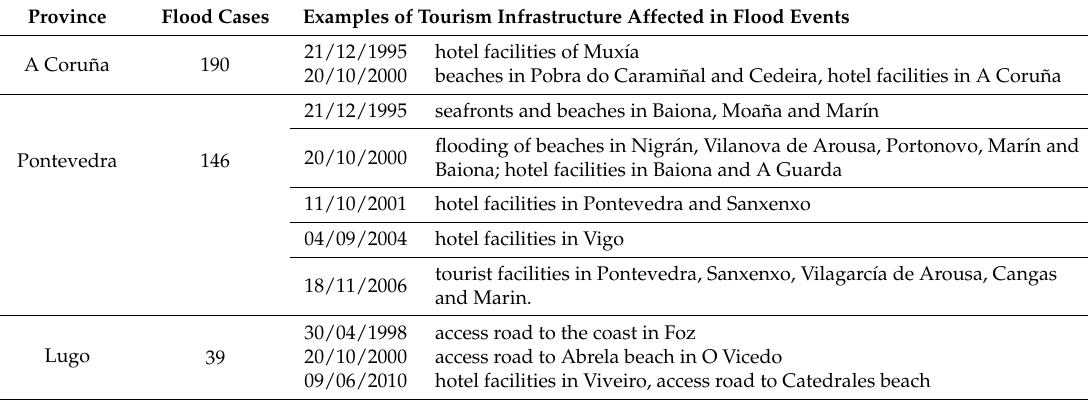
Table 7. Flood events in costal municipalities 1950–2011.